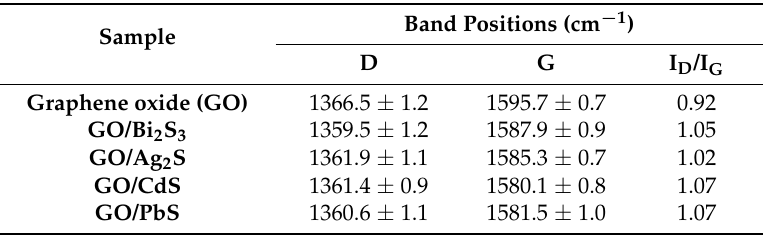
Figure 6. Raman spectra of graphene oxide and derived hybrids having the indicated metal sulfides (1000–3500 cm − 1 region). (1000–3500 cm − 1 region). Table 1. Raman shifts for G and D bands with the respective intensities ratio. Table 1. Raman shifts for G and D bands with the respective intensities